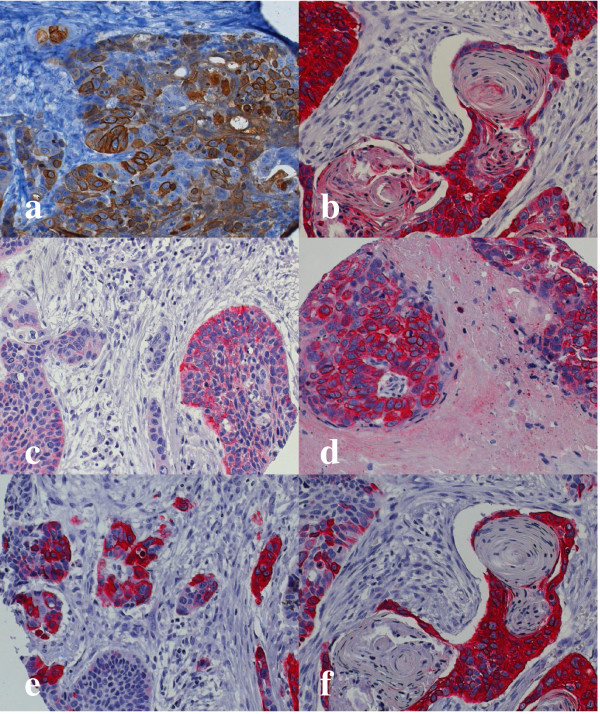
Immunohistochemical staining of oral squamous cell carcinoma with cytokeratin cytokeratin antibodies. a) cytokeratin 5/6 Antibody (magnification 20×) b) cytokeratin 19 antibody (magnification 20×) c) cytokeratin 8/18 antibody (Magnification 10×) d) cytokeratin 8/18 antibody (magnification 20×) e) cytokeratin 14 antibody (magnification 20×) d) cytokeratin 14 antibody (magnification 20×).